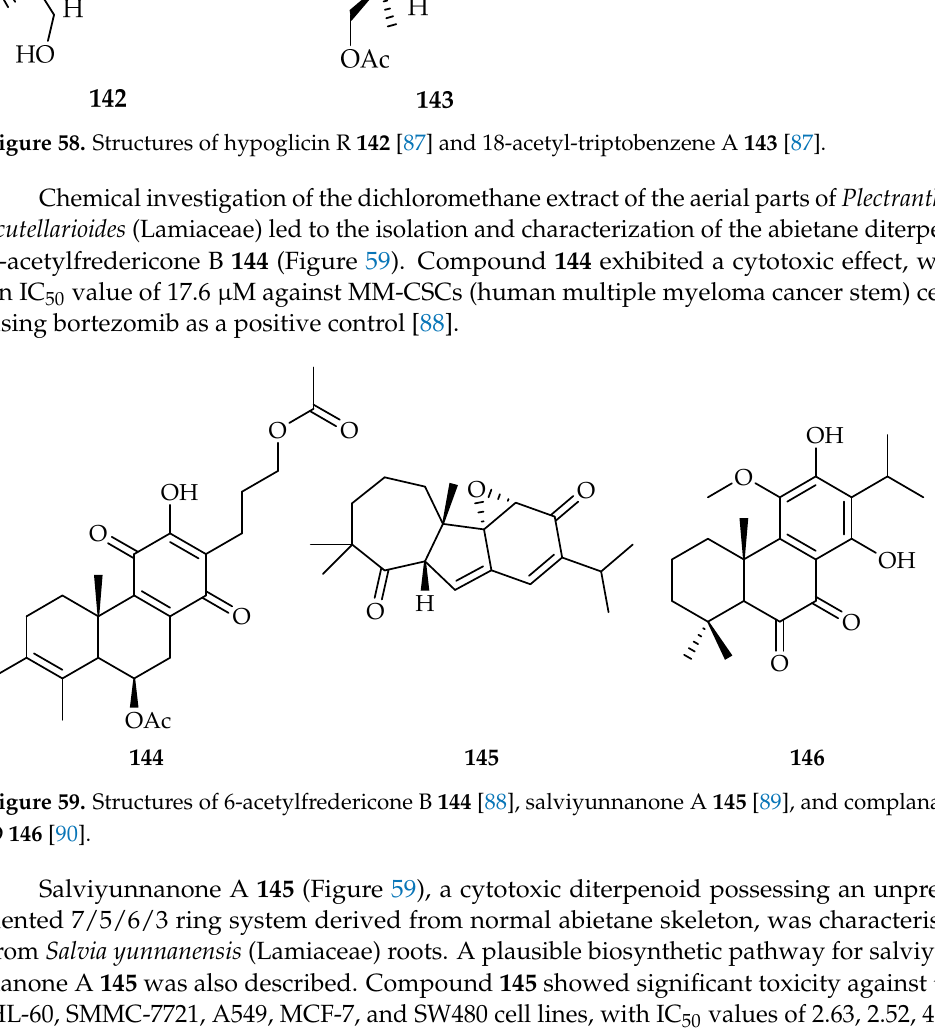
Figure 59. Structures of 6-acetylfredericone B 144 [88], salviyunnanone A 145 [89], and complanatin D 146 [90].